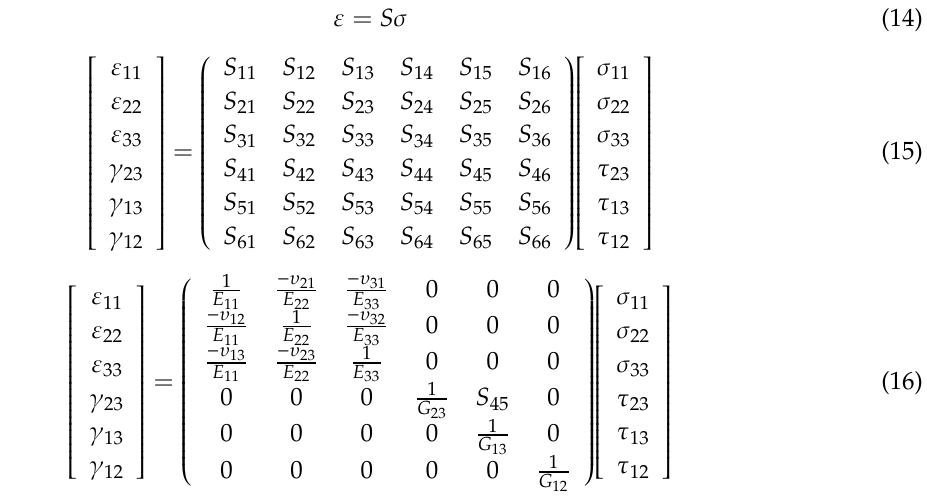
Calculated e ff ective homogenized properties of the meso-scale 3D four-dimensional